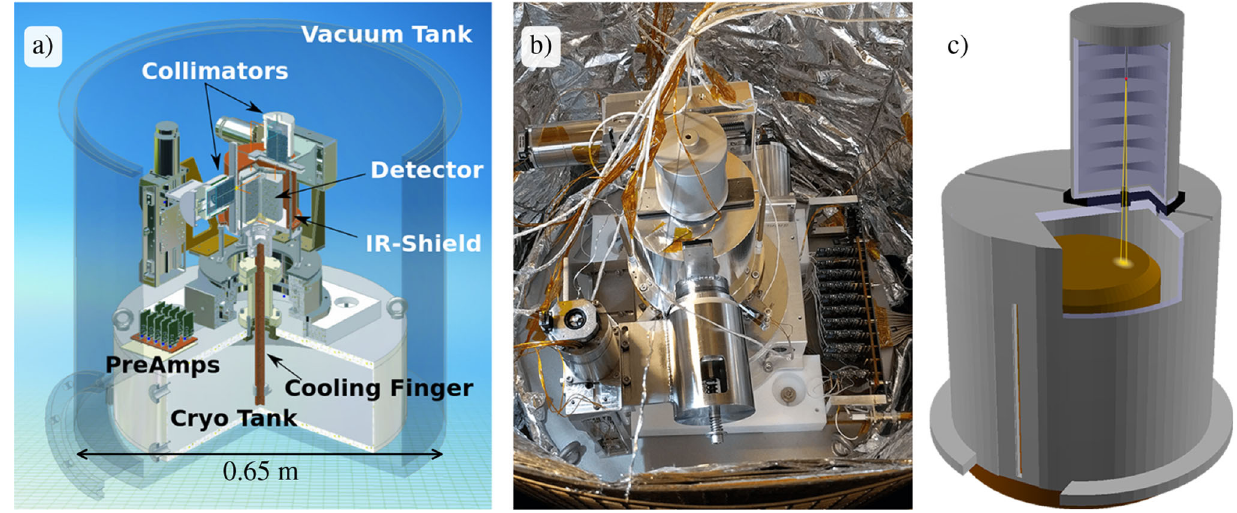
Fig. 1 a An illustration adapted from [15] and b a photo of the vacuum chamber of GALATEA with the main components marked in a . c Schematic of the central part of GALATEA with the infrared (IR) shield and the top collimator and an illustration of the beam-spot